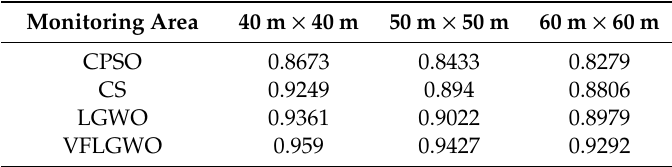
Table 9. Coverage rate in different size monitoring areas.